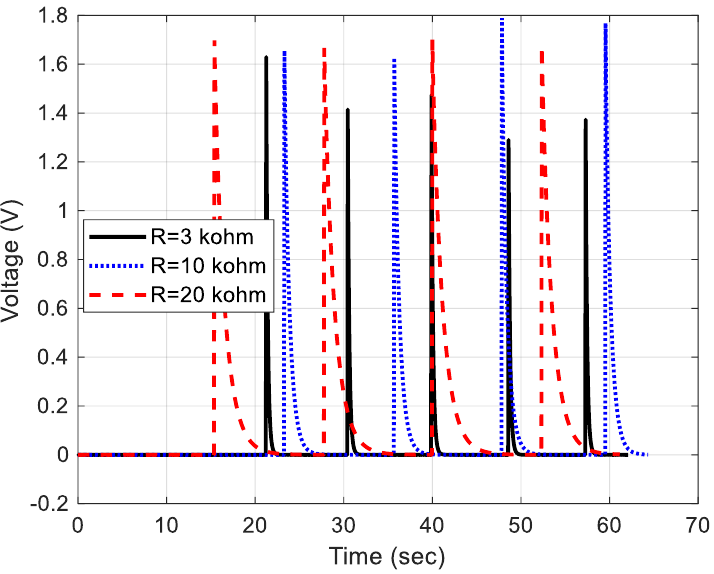
Figure 11. Sample of discharging voltage of LTC3588 when connected to the various external load; Cin = 22 μ F; Cout = 47 μ F; and f = 2.88 Hz.